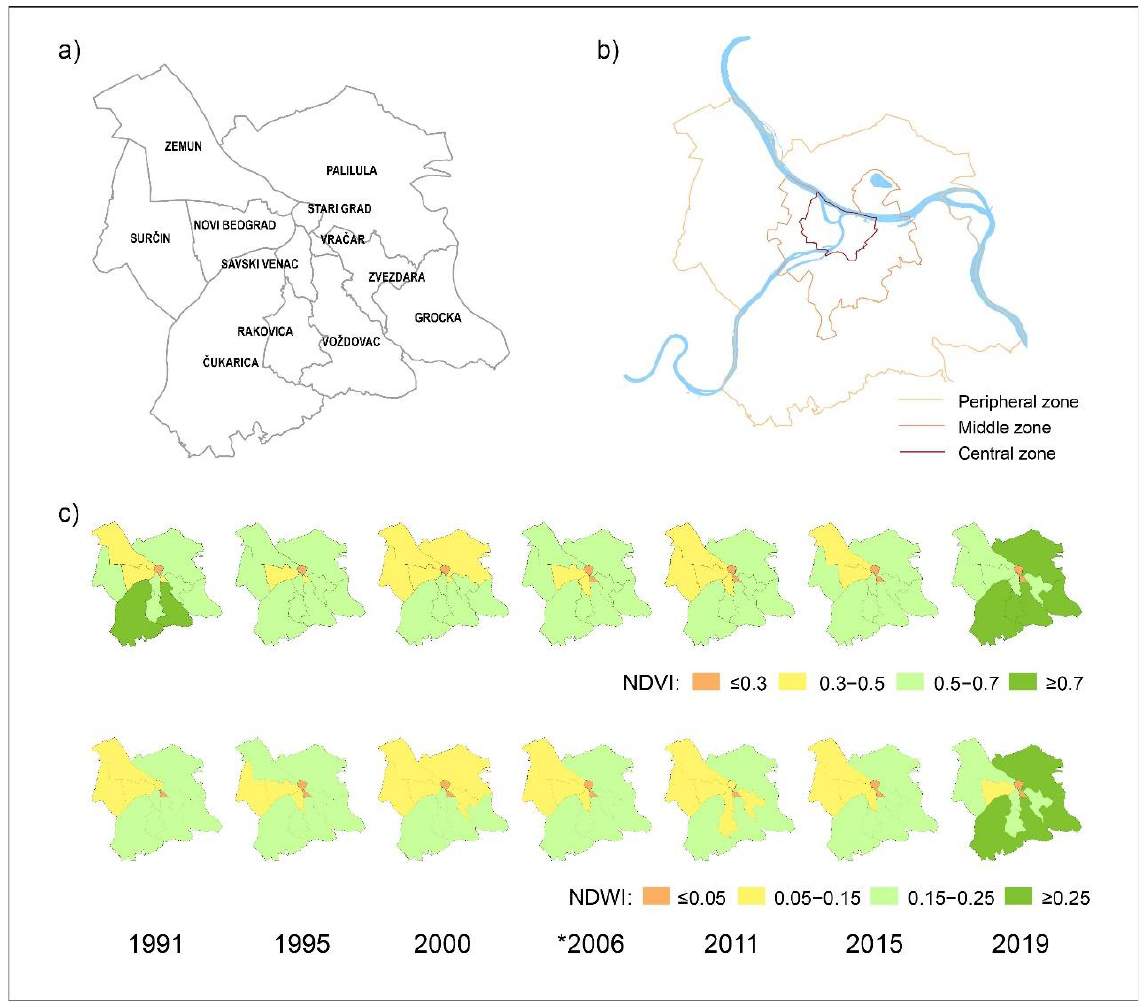
Figure 5. Municipalities ( a ) and spatial zones according to the General Urban Plan of Belgrade 2021 ( b ). Spatiotemporal changes of the annual NDVI and NDWI in 12 municipalities of Belgrade. ( c ) * Data for 2006 is based only on one image per growing season that met the criteria of clear atmospheric conditions.